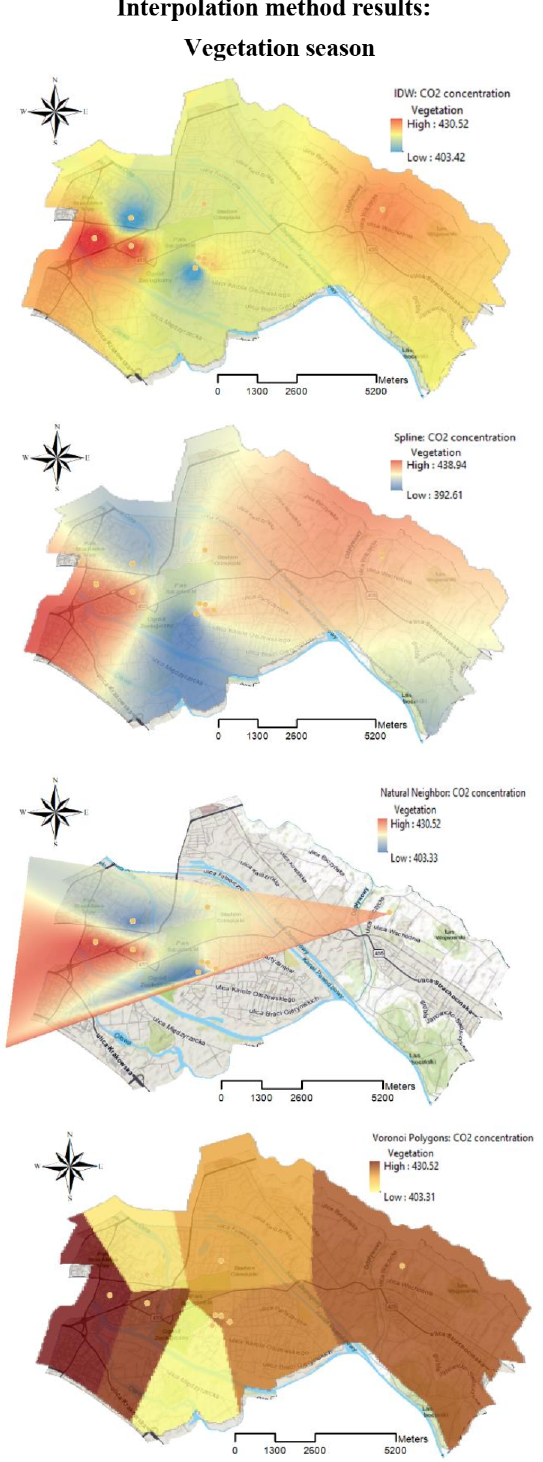
Figure 5. Interpolated surfaces of CO 2 distribution in the Vegetation season. 3-D view in ArcScene obtained for selected interpolation techniques (top to bottom): Inverse Distance Weighting (IDW), Spline, Natural Neighbour (NB) interpolation, Voronoi (Thiessen)